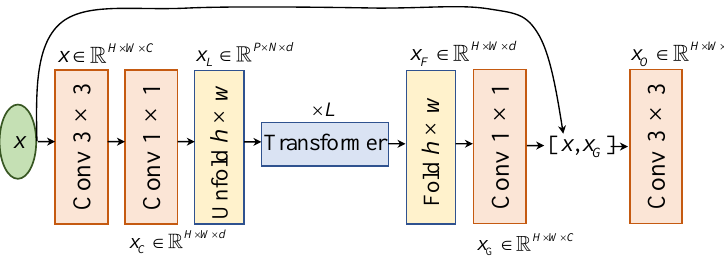
Figure 4. Mobilevit block. Compared to pure CNN or pure transformer, the Mobilevit block comprises the benefits of CNN and transformer together, and thus can get meaningful global context